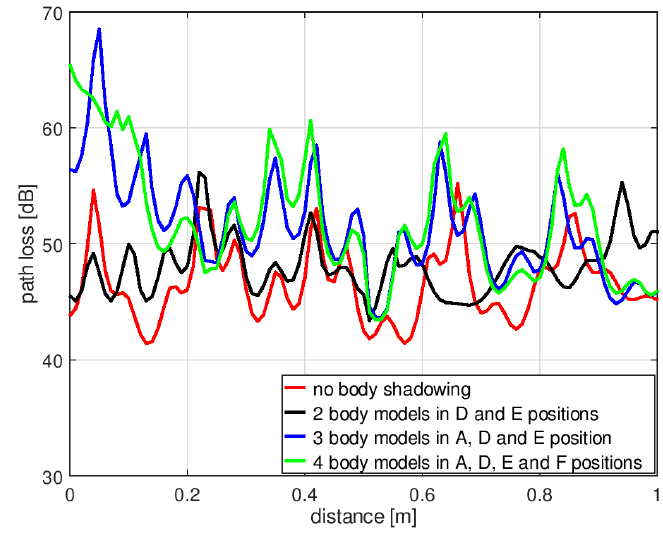
Figure 12. Results of path loss simulation for the second scenario in XGtd™.